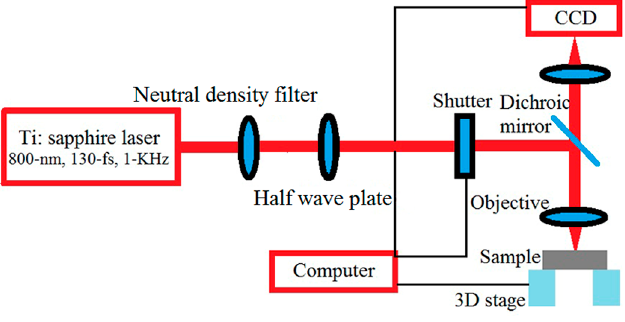
Figure 1. The schematic diagram of the femtosecond laser processing procedure.